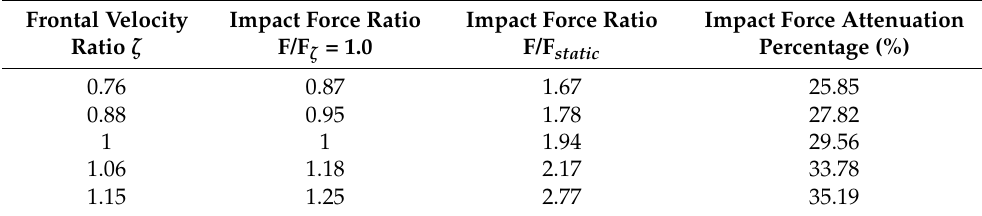
Table 4. Effects of the frontal velocity on the peak impact forces (F/F ζ = 1.0), the peak-static force ratio (F/F static ) at a barrier stiffness of 1.0 GPa and the load attenuation rate. Frontal Velocity Ratio